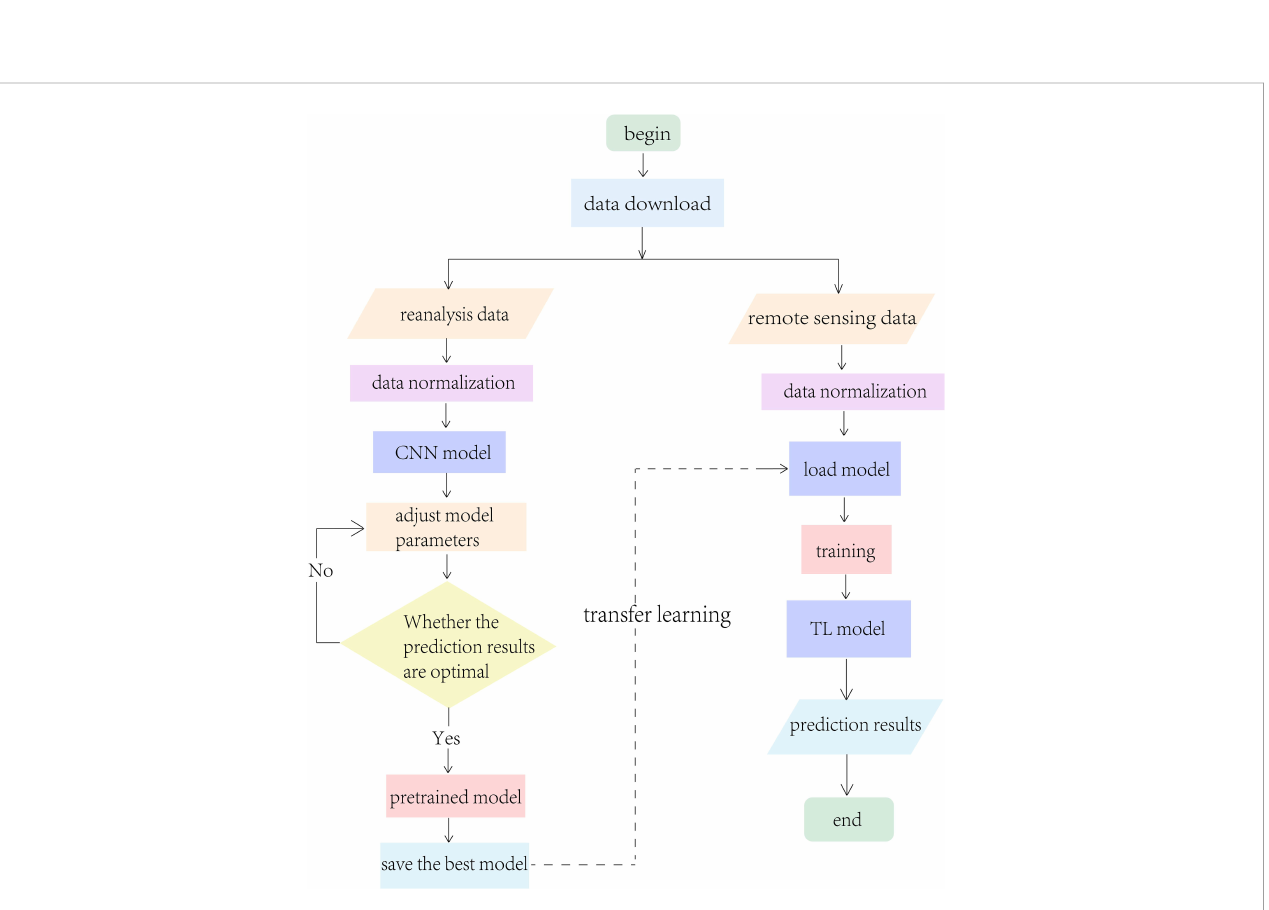
FIGURE 4 Framework of the proposed prediction